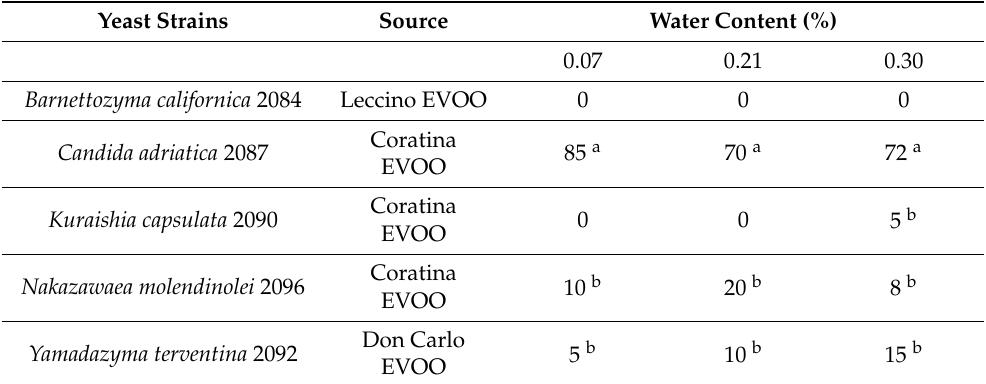
Table 5. Prevalence (%) of five oil-borne yeast strains inoculated in Coratina monocultivar EVOO with different water contents after three months of incubation. Yeast Strains Source Water Content (%) 0.07 0.21